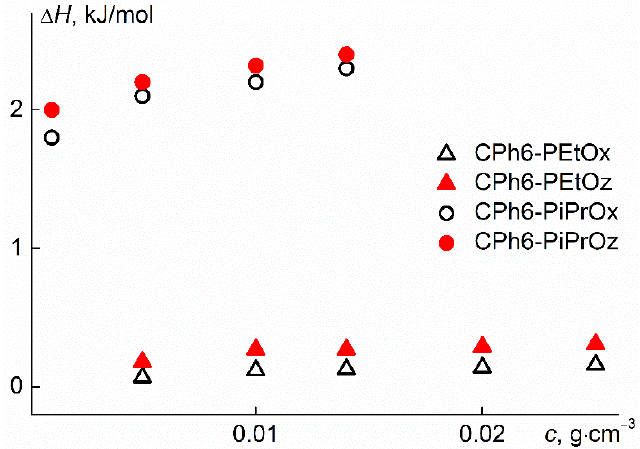
Figure 8. Concentration dependences of enthalpy for the studied aqueous solutions.